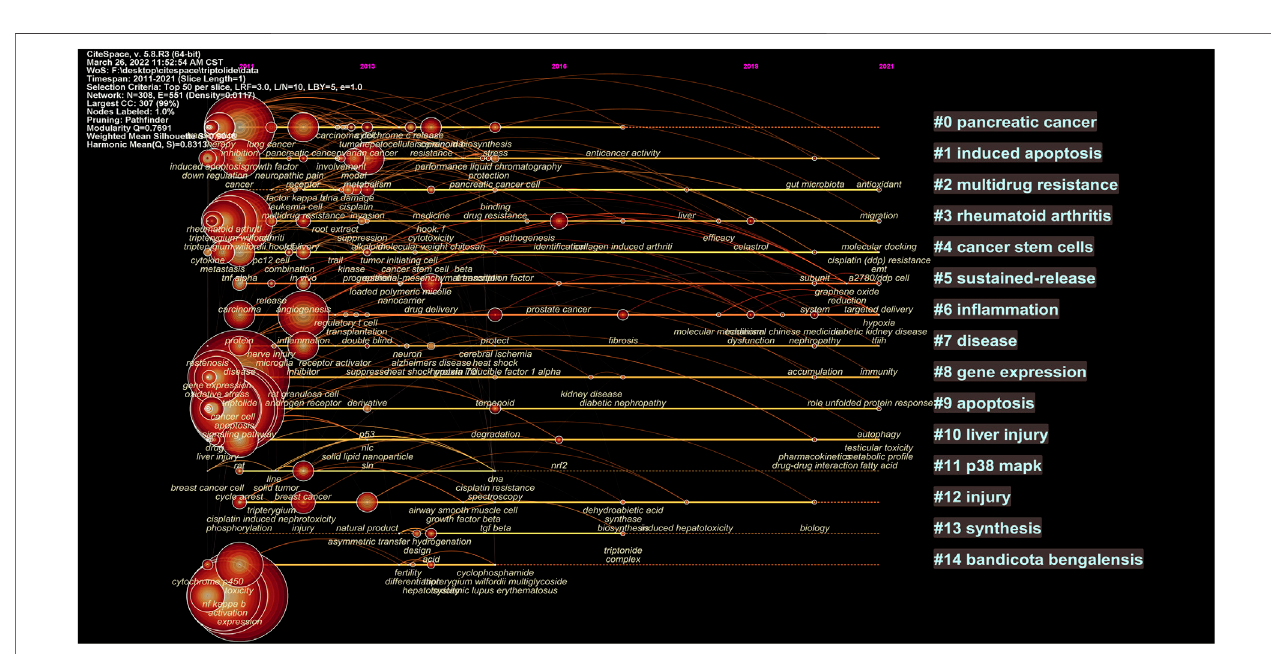
FIGURE 9 | Timeline of the cluster network of triptolide literature keywords from the WOS.